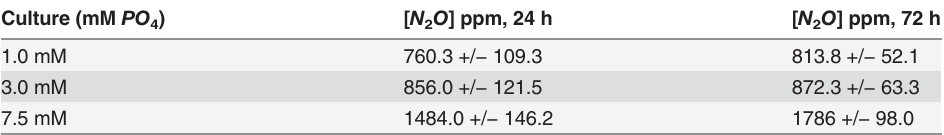
Table 1. Nitrous oxide concentration in P. aeruginosa cultures grown in glucose minimal medium at varying phosphate concentrations, normalized to 10 8 cells.